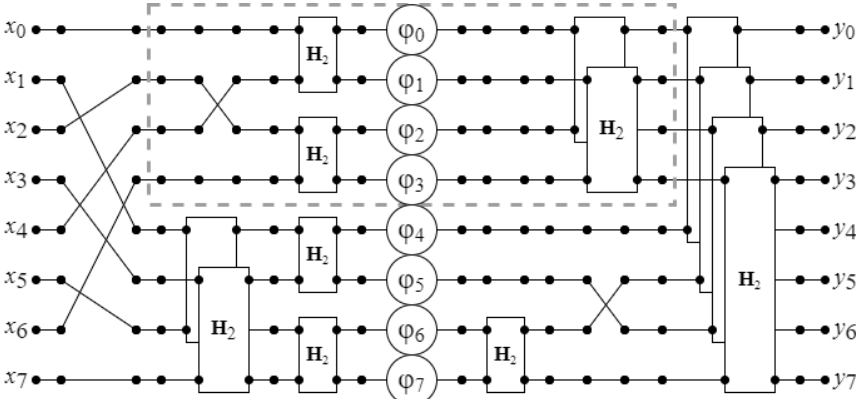
Figure 2. The data flow graph of the proposed algorithm for computation of 8-point